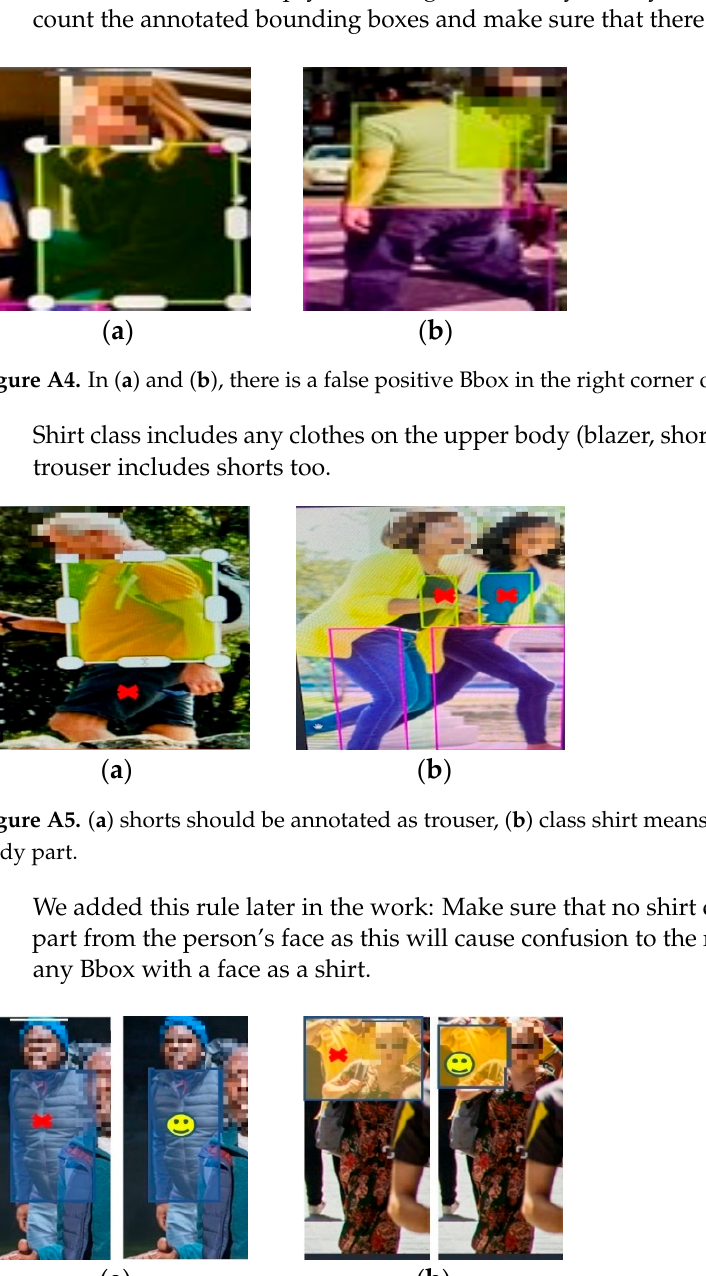
4. Be careful with the empty Bounding boxes that you may draw by mistake. Always count the annotated bounding boxes and make sure that there are no extra free boxes.